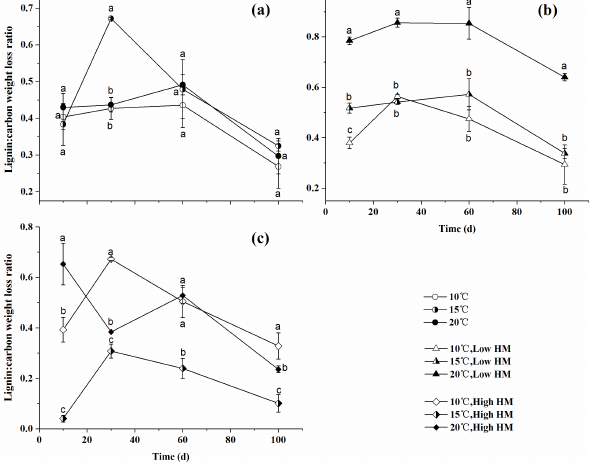
Figure 4 : Changes in chemistry characters of lignin: carbon weight loss ratio (L/C) in Typha incubated at three temperatures and two heavy metal (HM) levels. Legend: (a) control treatment; (b) three temperatures and low heavy metal levels; (c) three temperatures and high heavy metal levels. Different lowercase letters on the top of the bars denote significant differences among different treatments at the same sampling time (n=3, P < 0.05).